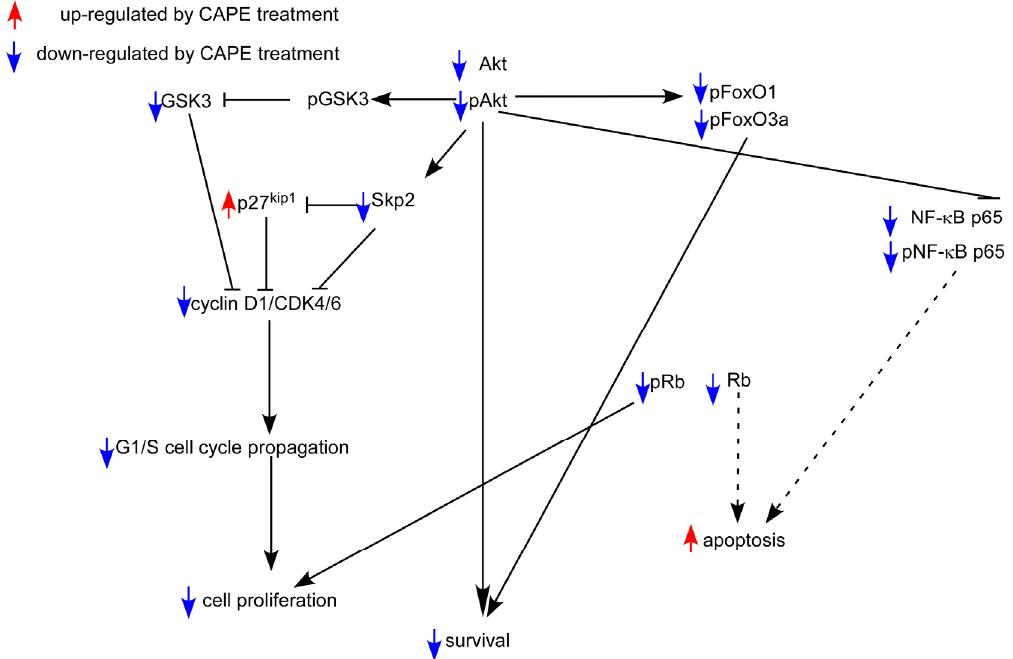
Figure 8. Putative model of anti-cancer effect of CAPE in TW2.6 human oral cancer cells. Protein abundance or activity being stimulated by CAPE treatment are labeled with red upward arrows, while those being suppressed by CAPE treatment are labeled with blue downward arrows. Dash lines indicated possible